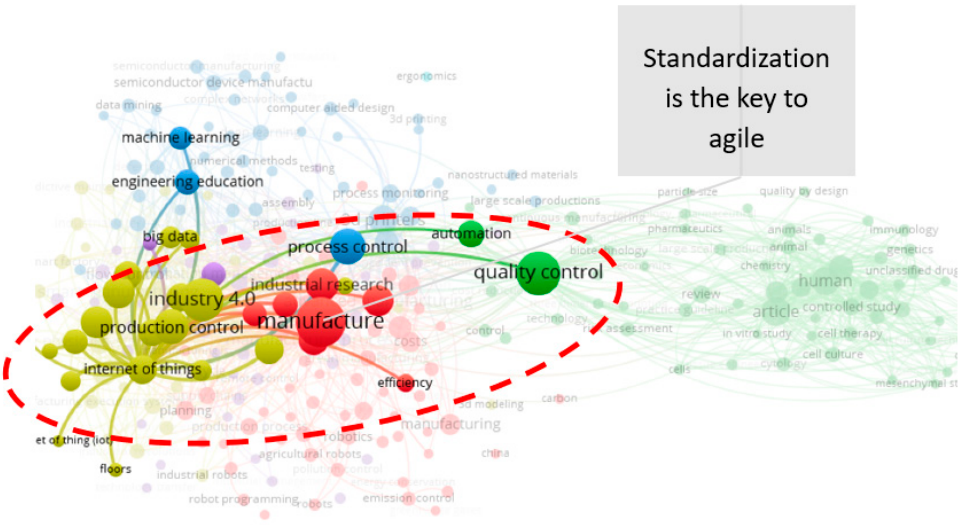
Figure 17. VOSviewer: The first look at the STANDARDIZED world of the INDUSTRY 4.0 land ‐ scape.